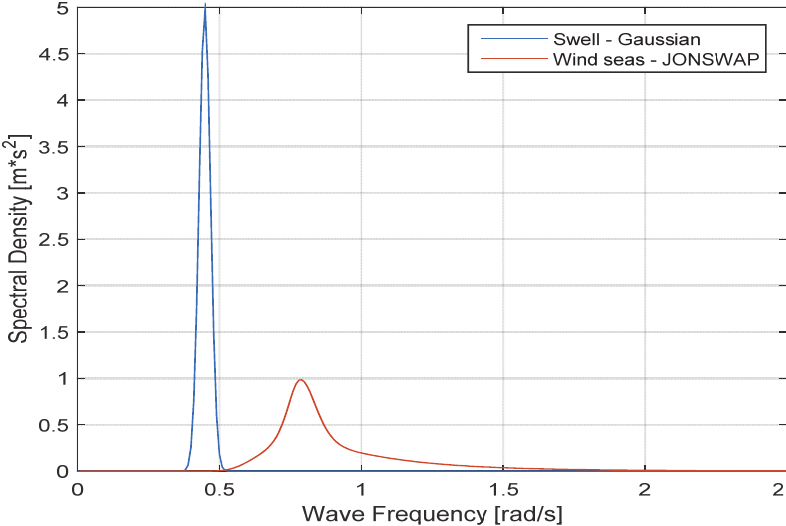
Figure 6: Energy density for wind seas and swell.